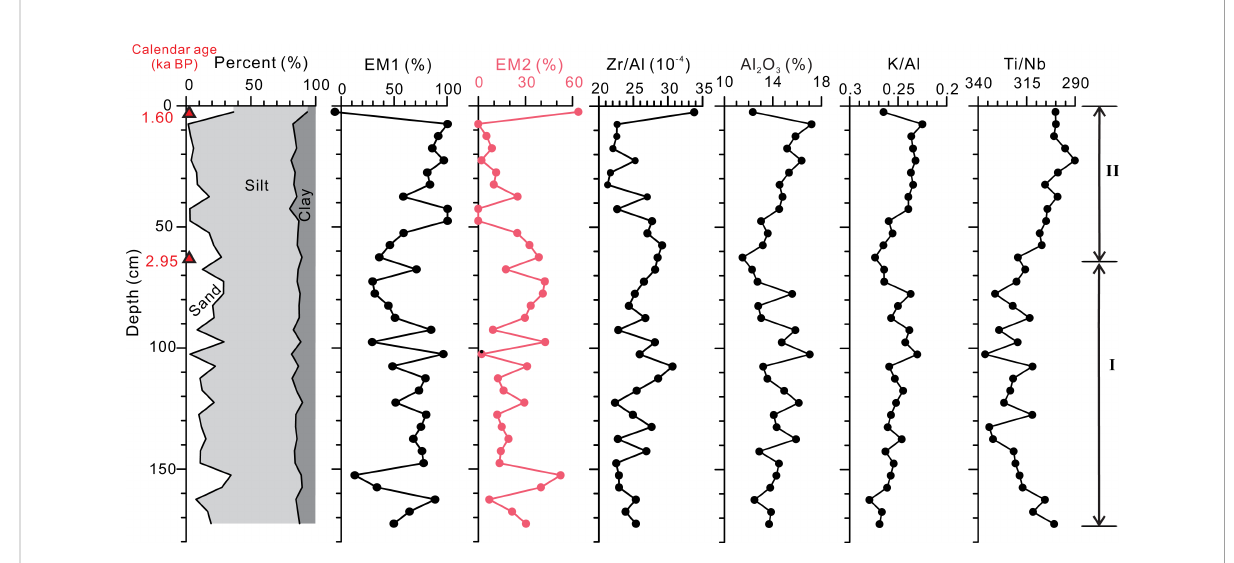
FIGURE 5 Sediment compositions and elemental proxies of core A1. Red triangles on the depth scale marked 14 C dates. Sub-segments were labelled on the right